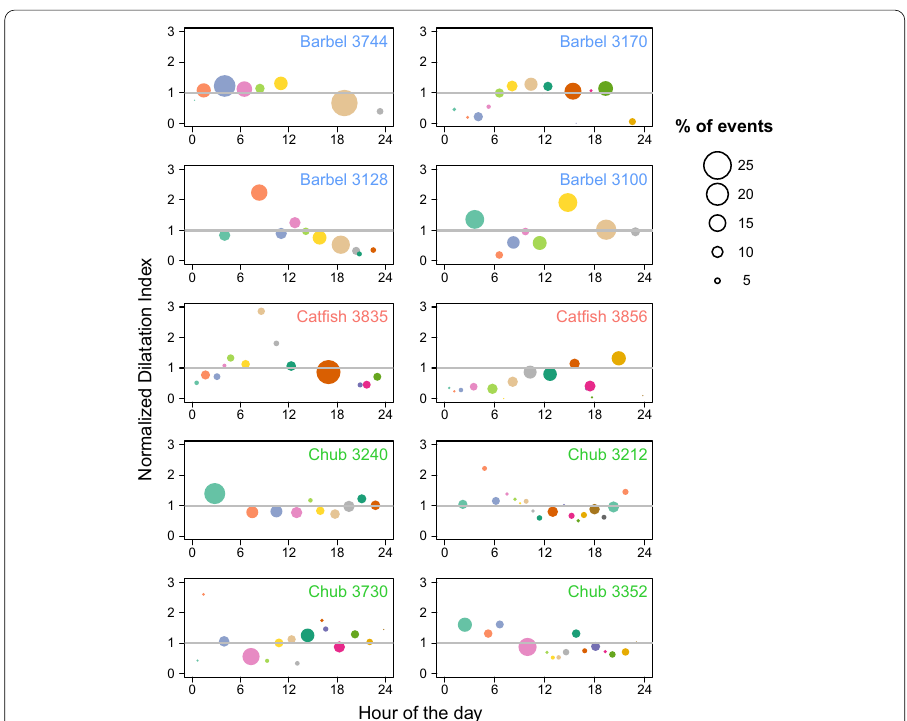
Fig. 5 Analysis of the event networks’ community structure. The plots display the communities characteristics for every fish. Each point represents a community with the average resting time on the x-axis and the community dilatation index on the y-axis. The community dilatation index is normalized by the dilatation index DI . The size of the dots is proportional to the fraction of events